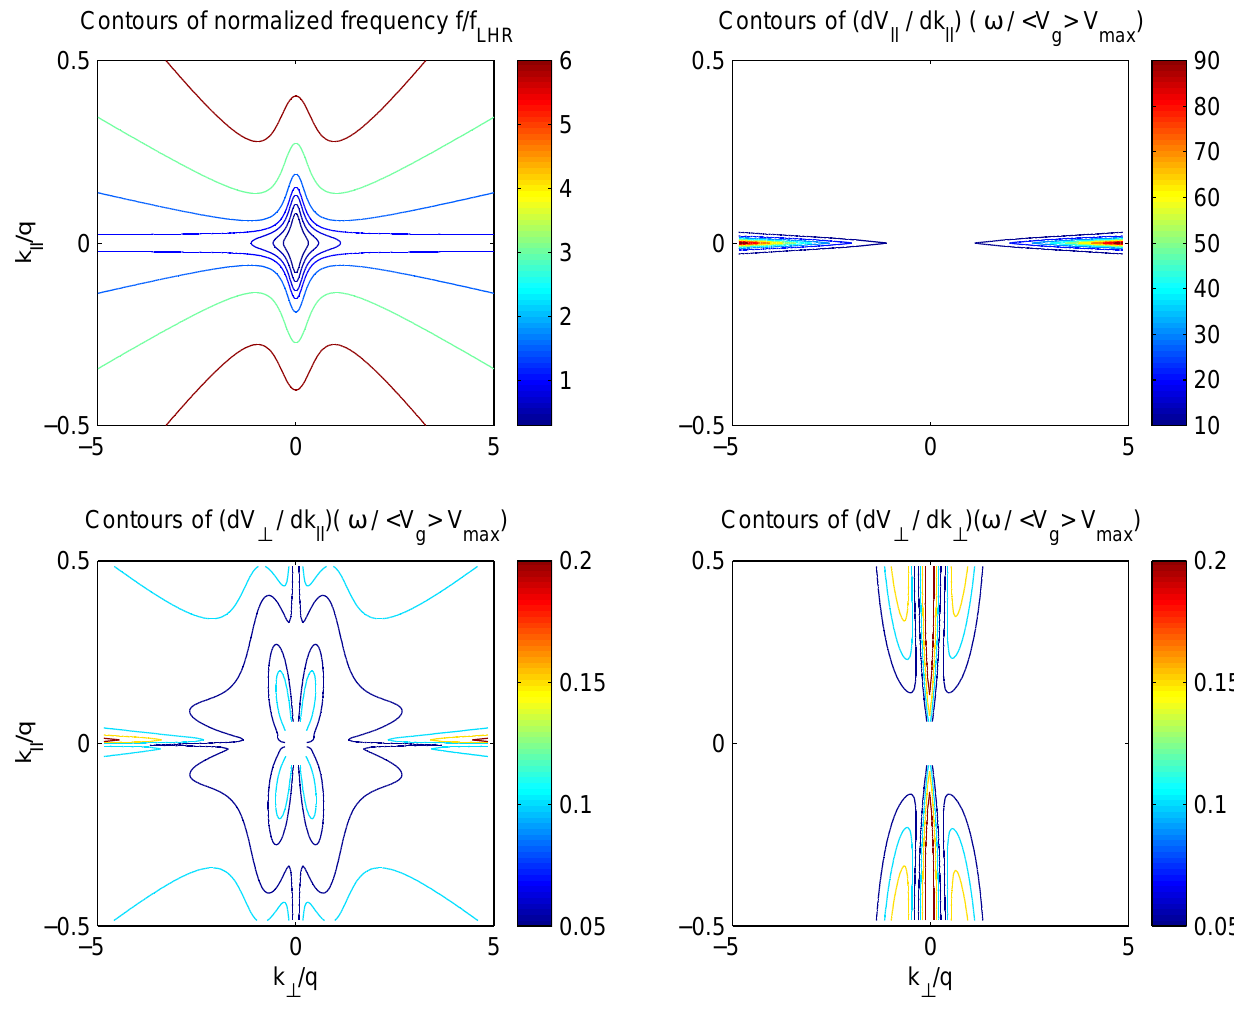
Fig. 1. Contours of normalized frequency and reflection parameters. Note different colour bars associated with different subplots. Only the parameter shown on the upper right panel greatly exceeds unity and, thus, determines the wave